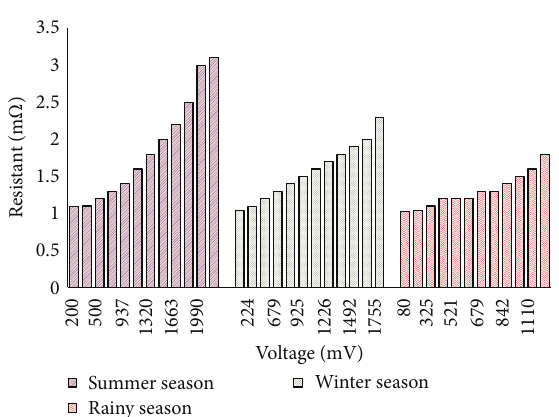
Figure 9: Comparison of voltage versus current in the duration of 11.00 am to 1.00 pm in summer, winter, and rainy season. in rainy season, the highest amount of current 756 mA is obtained at a voltage of 1437 mV.